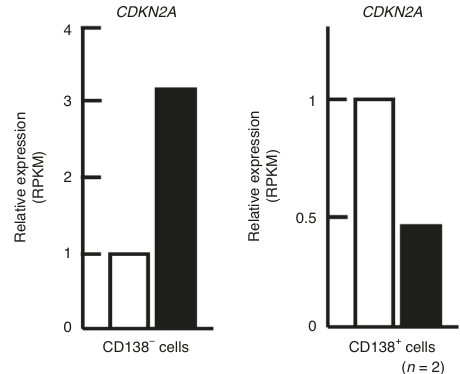
Fig. 7 Cell senescence in SMM. The expression of the cell senescence marker gene CDKN2A in CD138 + myeloma cells and CD138-expressing nonmyeloma cells was measured by RNA sequencing. Black bars represent clinically diagnosed SMM